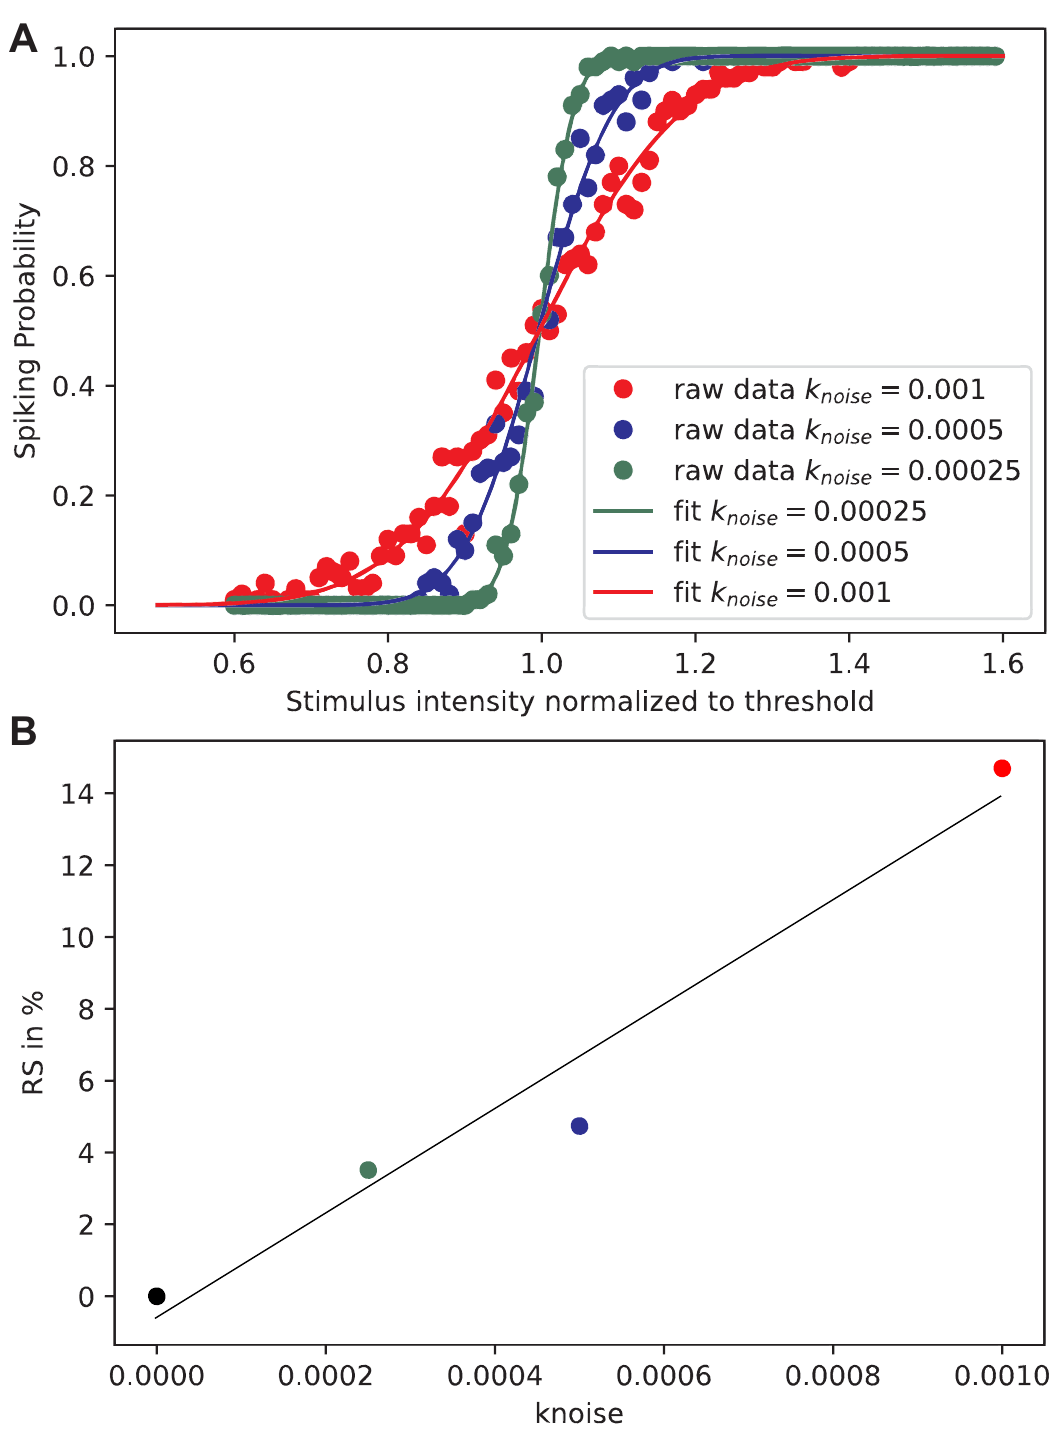
Fig 4. RS increases linearly with knoise. A: Spiking probability functions for three knoise values. Numerical evaluation was performed at 100 intensities, from 0.6 threshold to 1.6 � threshold in 0.01 steps. For each point 500 runs were performed to estimate the spiking probability, then a cumulative Gaussian distribution was fitted. Electrode distance 500 μ m, myelinated axon d = 1 μ m. B: RS values from A as functions of knoise underlines the assumption that for small knoise values RS is proportional to knoise. Linear fit: RS = 14458 � knoise– 0.588, R 2 =